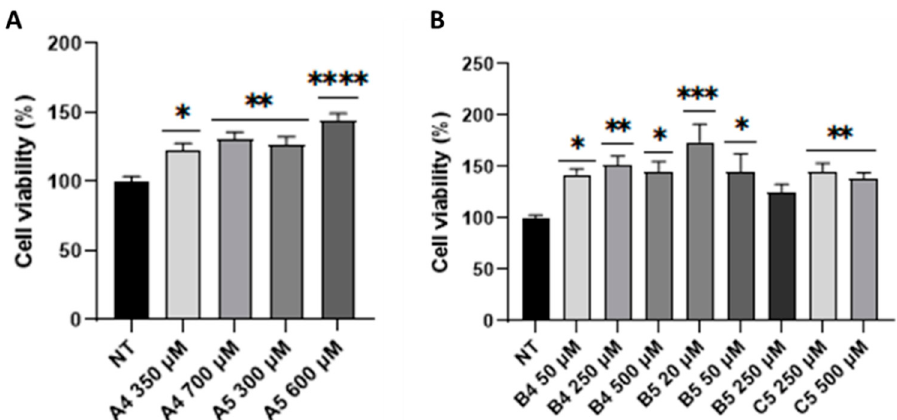
Figure 4. MTS assay on SUP-T1 cells at 4 h after single GEs treatments ( A , B ). Asterisks indicated p < 0.05 (*), p < 0.01 (**), p < 0.001 (***), and p < 0.0001 (****) compared with non-treated (NT) cells, ANOVA One-Way test. Analysis was performed on three independent biological replicas. Data are reported as mean ± SEM.